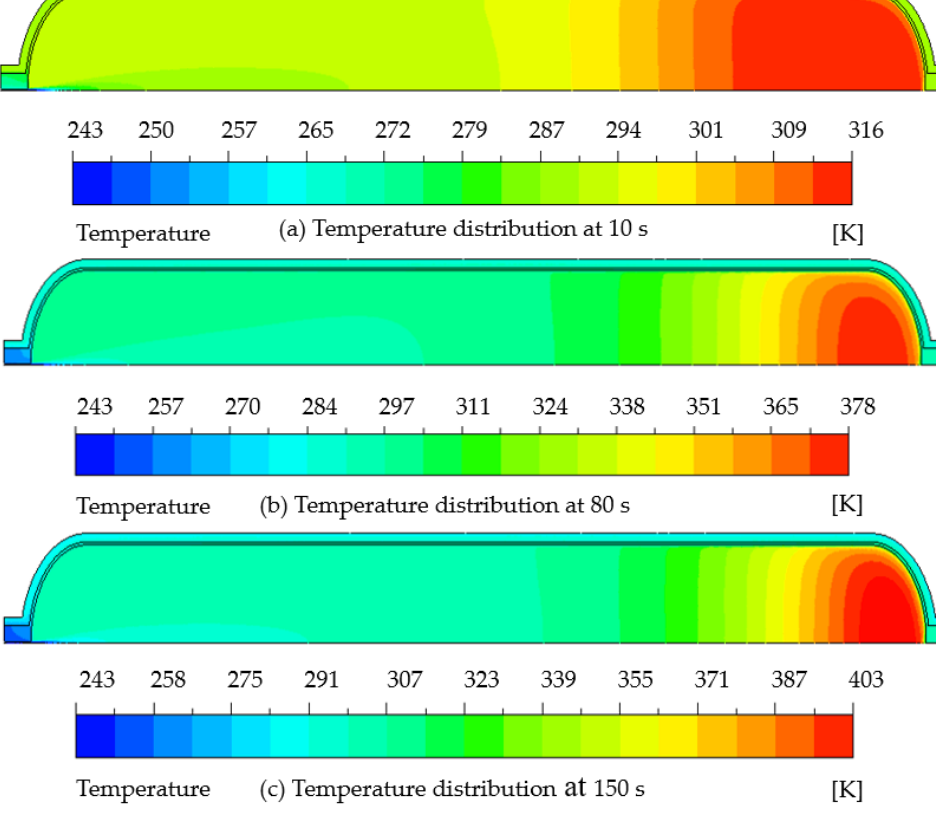
Figure 6. Measured and predicted temperature evolution.